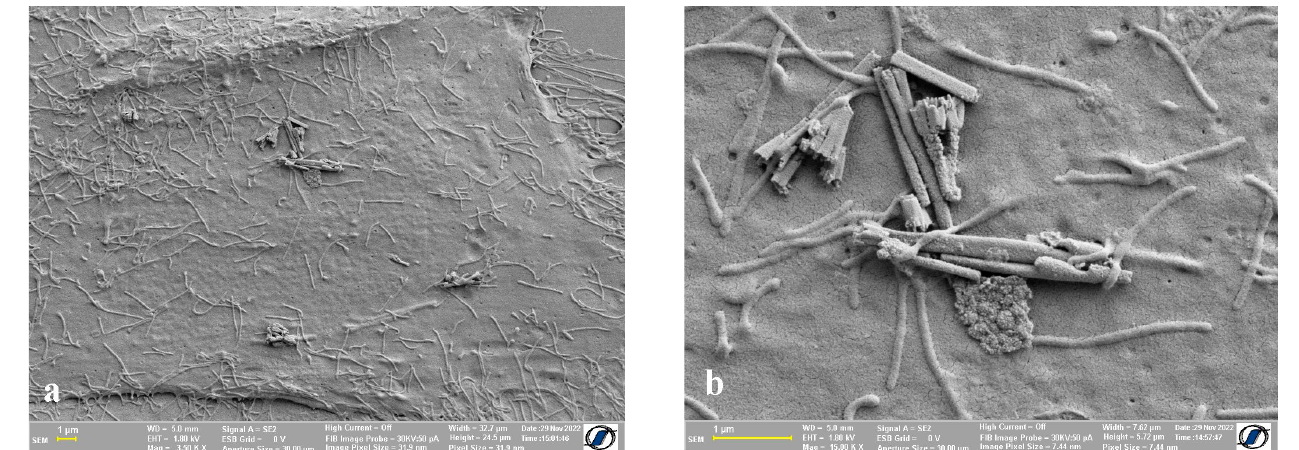
Figure 5. Human osteosarcoma cells with Fe-Co nanowires: ( a ) an agglomeration of Fe-Co nanowires on the cell surface; ( b ) close-up of the nanowires adherent on the cell surface.